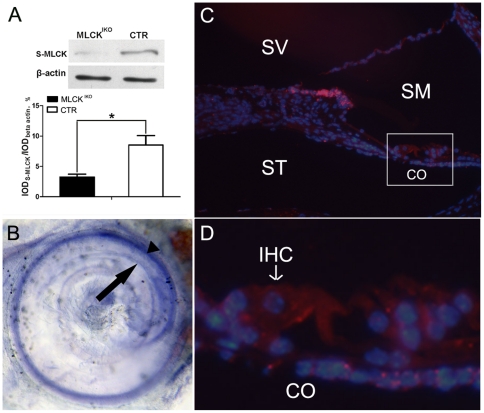
MLCK expression in mouse cochleae.(A) Upper panel: Western blot analyses demonstrate that S-MLCK (short MLCK) is expressed in mouse cochleae. Samples of 25 µg of cochlear protein were separated on 5% SDS-PAGE. The K36 antibody was used as the primary antibody. The results showed one band of approximately 130–140 kD (short MLCK should be 108 kD). Lower panel: Quantitative analysis of Mylk gene expression in MLCKIKO (solid symbol) and CTR (open symbol) mice. The bars represent the means of IODS-MLCK/IODβactin ±SD (integral optical density, IOD). The * symbols denote statistical significance at the level of P<0.05 vs CTR. (B) Whole-mount in situ hybridization for Mylk RNA in the inner ear. Mylk mRNA is expressed predominantly in the stria vascularis (arrowhead) and is moderately expressed in the organ of Corti (arrow). (C) Immunochemistry of K36 (red) in cross-sections of cochleae from wild-type mice. The nuclei were stained (blue) with Topro. (D) High-magnification view of the organ of Corti. S-MLCK: short MLCK; CO, the organ of Corti; SV, scala vestibuli; SM, scala media; ST, scala tympani; IHC, inner hair cell.